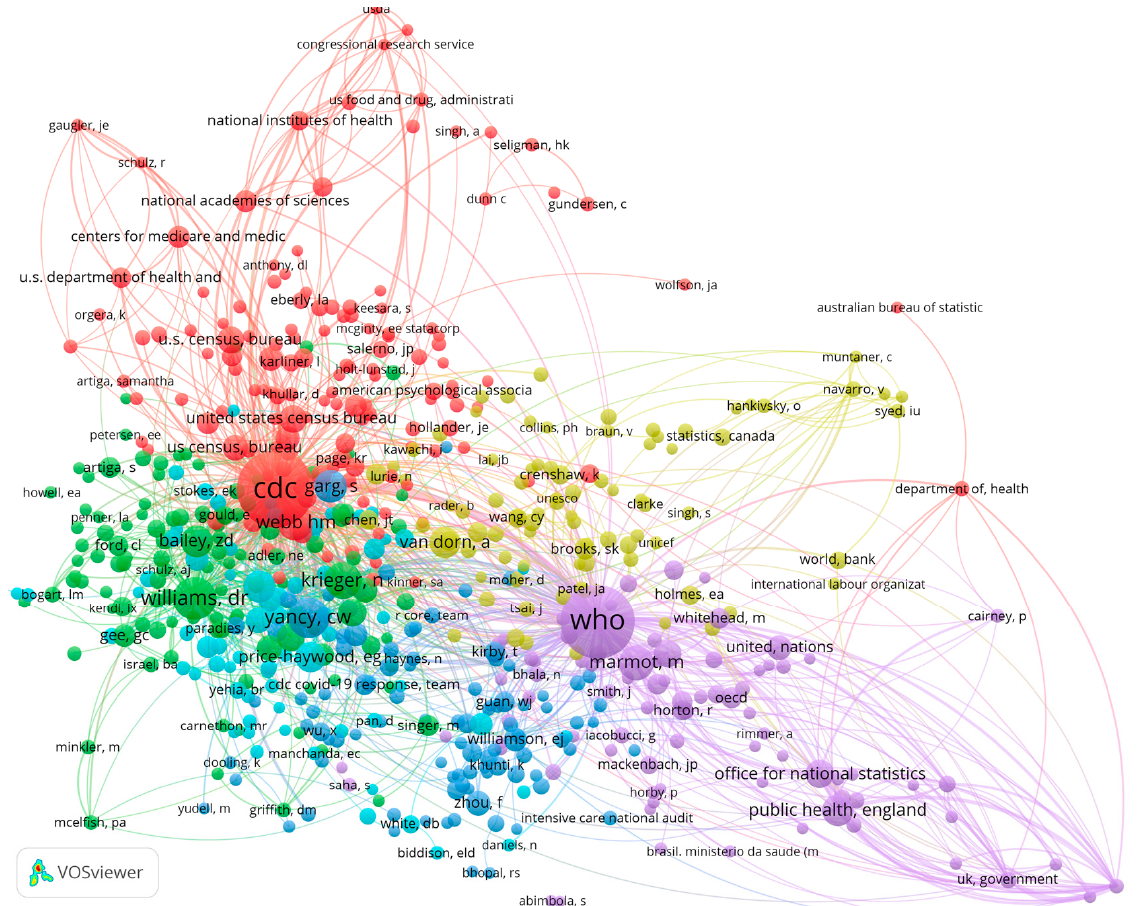
Figure 6. The authors co-citation network of cited references. Note(s): Color represents clusters, linked lines represent co-citation relationships, and node sizes represent citation frequencies.